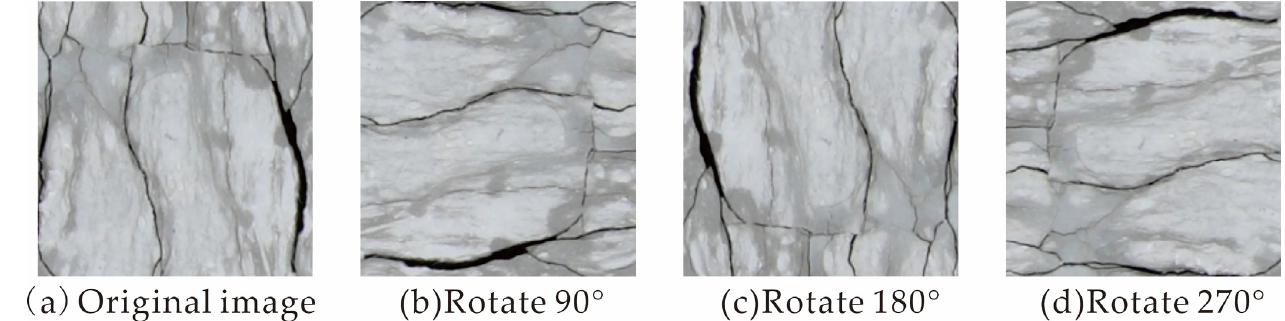
Figure 7. Rotation dataset.